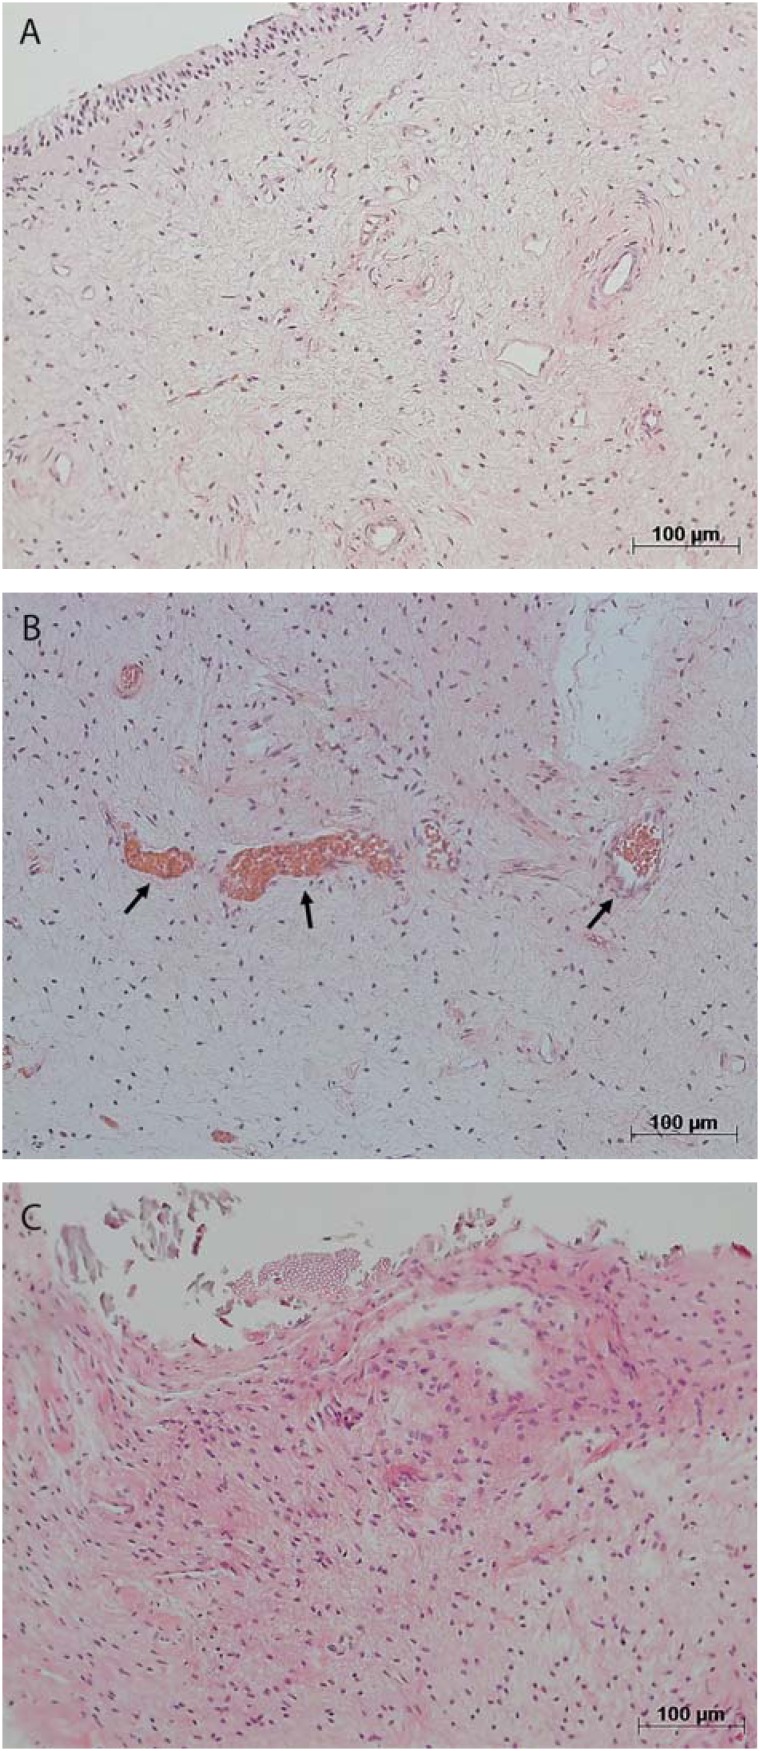
Representative images showing dental pulp with absence of inflammatory infiltrate (score 0) and preserved blood vessels in control group (A); absent inflammatory infiltrate (score 0) and dilated and congested blood vessels (arrows) in at-home bleaching group (B); and mild inflammatory infiltrate (score 1) in in-office bleaching group (C). Hematoxylin & eosin staining, original magnifications 100X;A-C